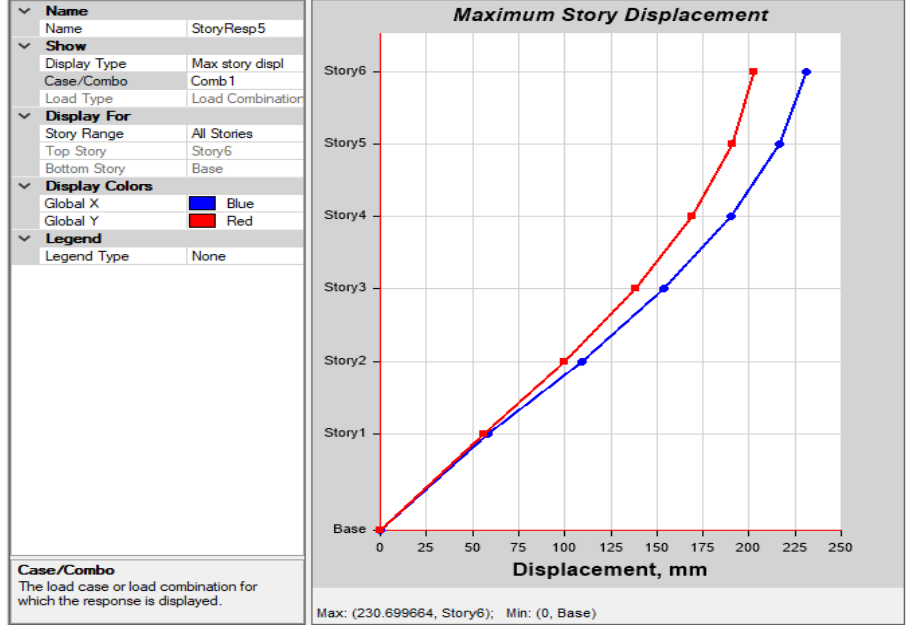
Figure 14. Maximum story displacement.